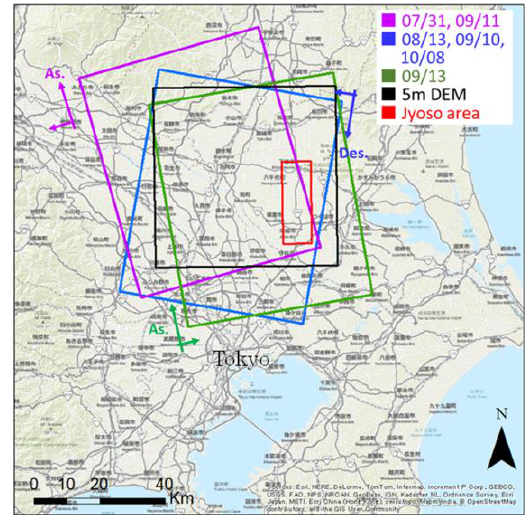
Figure 1. Coverage of PALSAR-2 data in the Kanto region of Japan and the study area (Joso city) in red